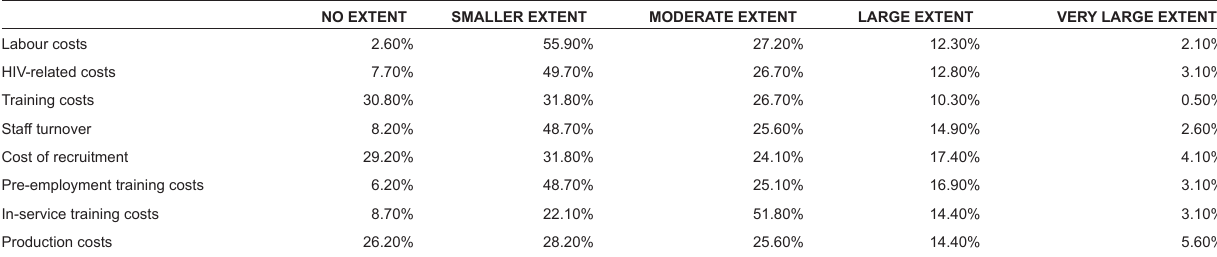
TABLE 13 Impact of HIV/AIDS on labour costs, training costs, staff turnover, cost of recruitment, pre-employment training costs, in-service training costs and production costs (% of respondents) No EXTENT